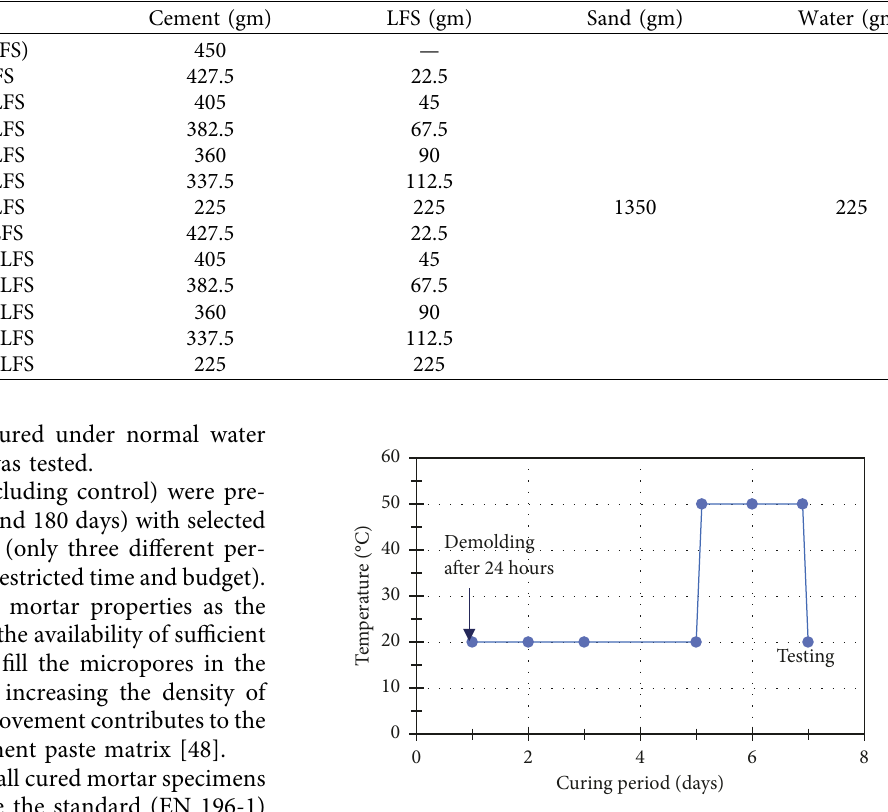
Figure 5: Temperature variation with time for HTAC samples.